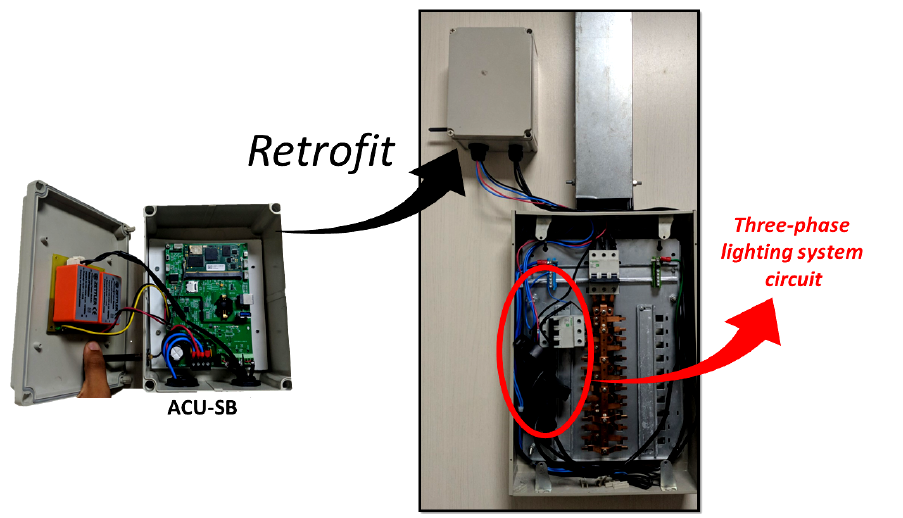
Figure 9. Retrofit method for